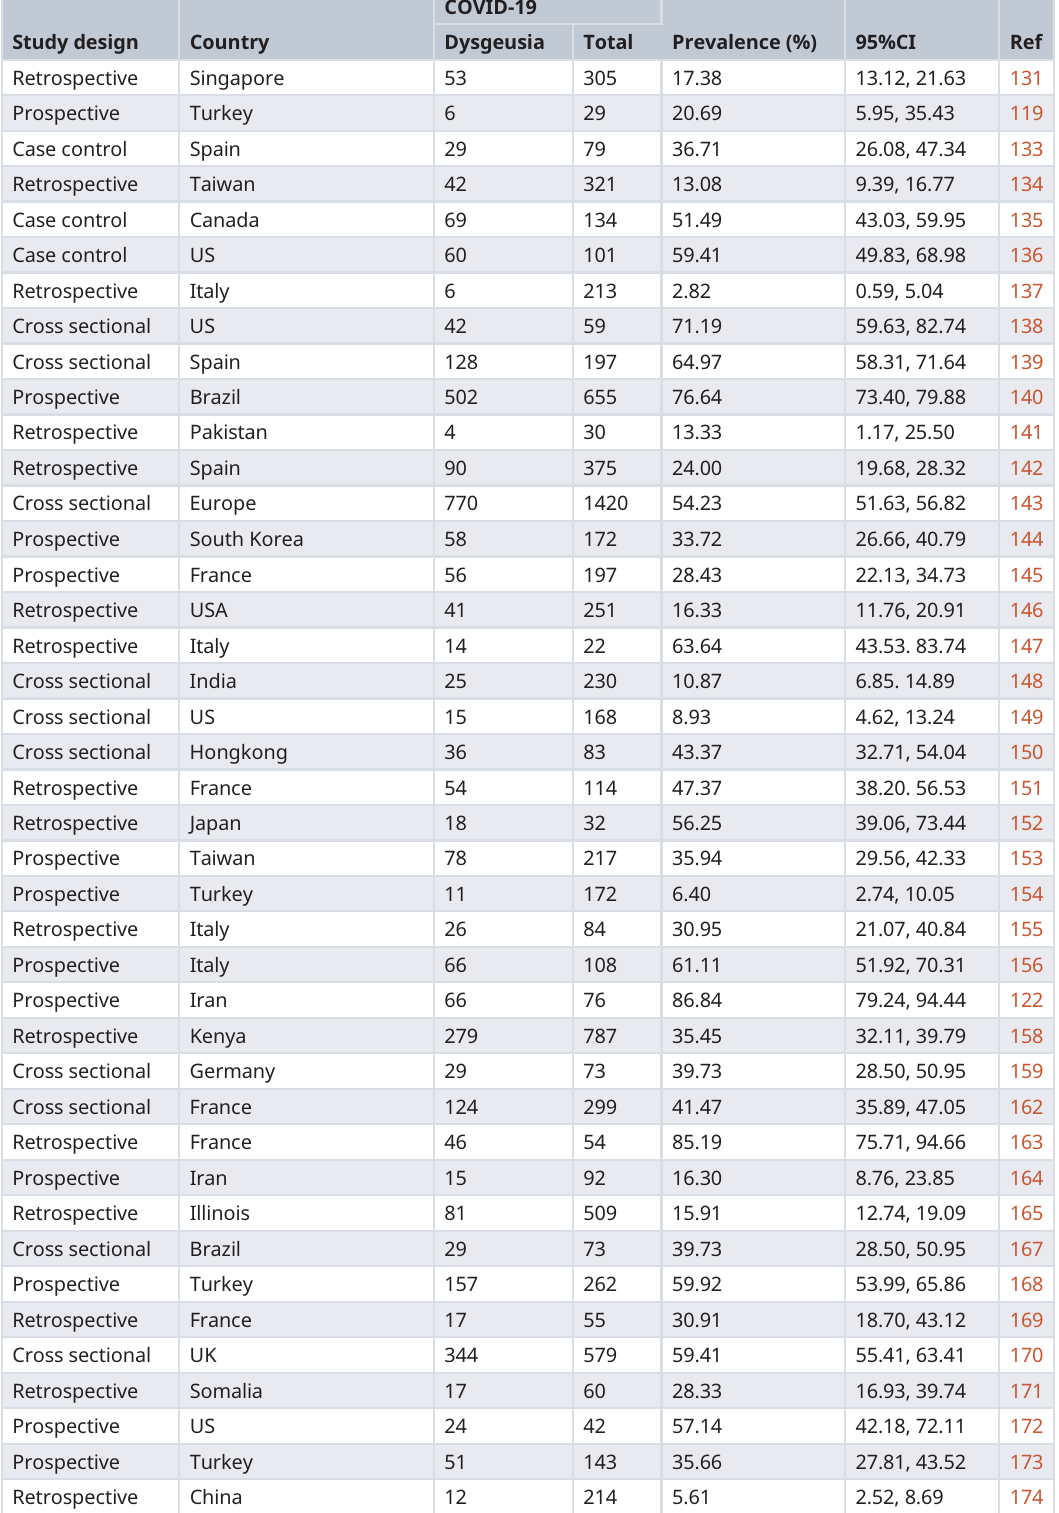
Table 2. The prevalence of dysgeusia among COVID-19 patients around the globe.